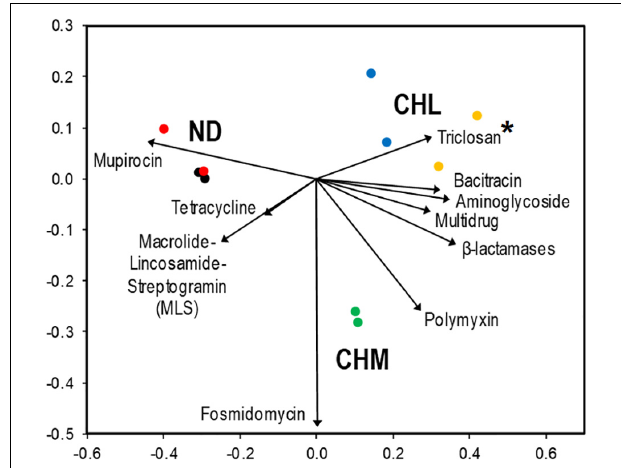
FIGURE 2 | nMDS ordination plot based on the composition of antibiotic resistance genes obtained from DWDS communities. The contribution of ARG categories that explained ∼ 93% (SIMPER analysis) of the dissimilarity within all samples is represented by the size and direction of vectors. Disinfectant: no disinfection (ND), chlorine (CHL), and chloramine (CHM). Sites: DWDS A ( • ), DWDS B ( • ), DWDS C ( • ), DWDS D ( • ), and DWDS E ( • ). *Genes conferring triclosan, an antimicrobial agent, are also included in this analysis. Stress value: 0.021; Coordinate 1: 67.8%; and Coordinate 2: